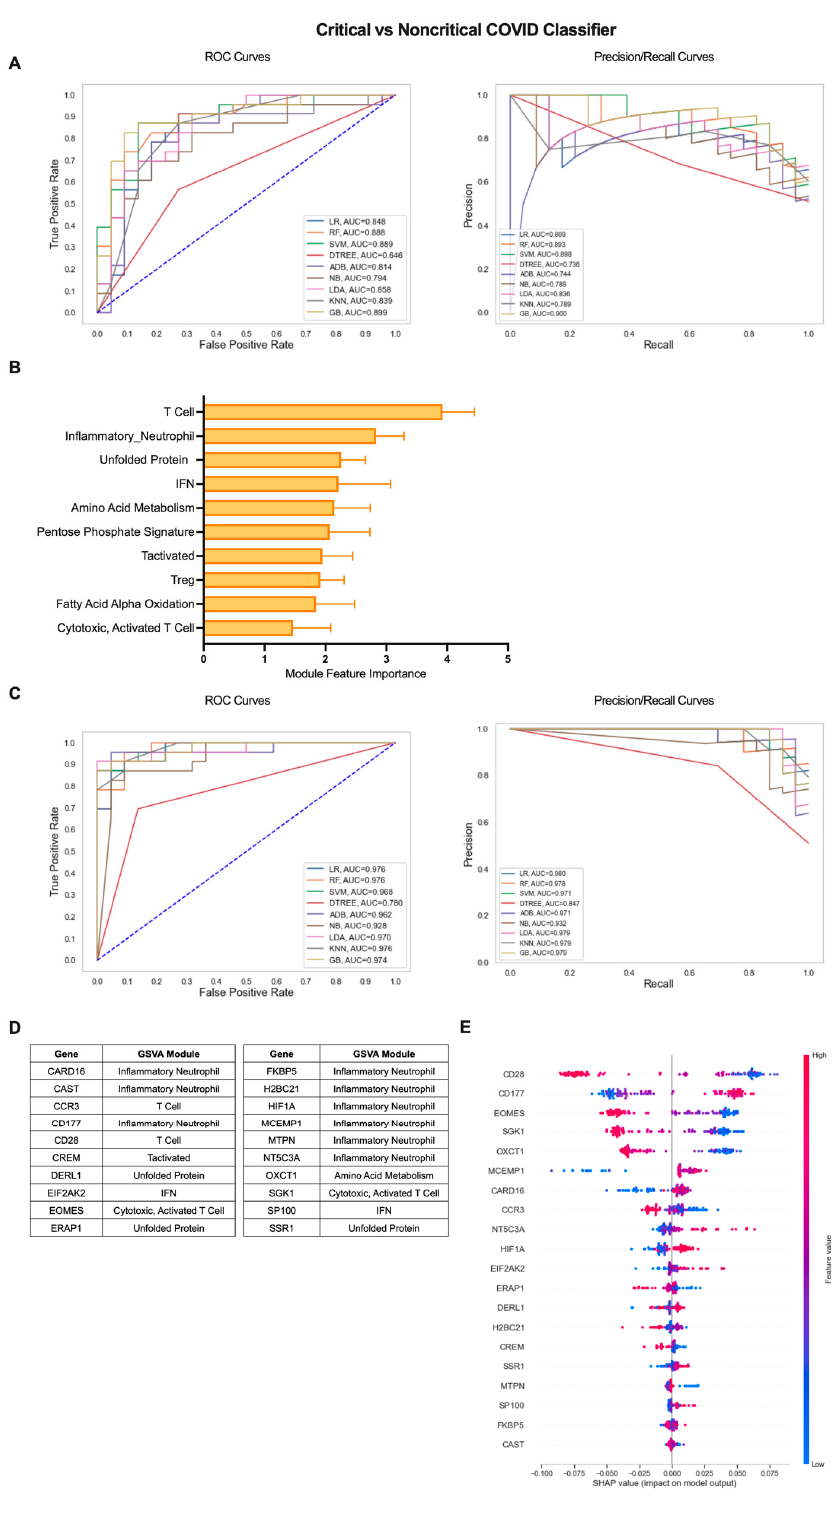
Figure 4. Iterative ML critical vs. non-critical COVID-19 patient classifier results. ( A ) Representative ROC and PR curves from the first ML pipeline iteration for the critical vs. non-critical COVID-19 patient classifier. ( B ) Bar graph of feature importance values for the top 10 gene modules resulting from the second ML pipeline iteration. ( C ) Representative ROC and PR curves from the third ML pipeline iteration for critical vs. non-critical COVID-19 patient classifier. ( D ) Top 20 gene features resulting from the third ML pipeline iteration. ( E ) SHAP summary plot depicting the magnitude and directionality of relationships between the top 20 gene features and critical COVID-19